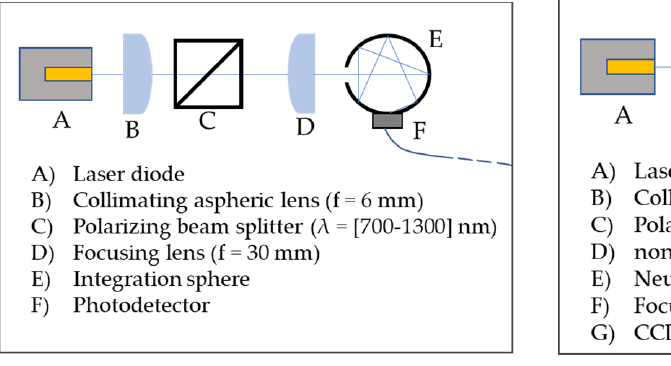
Figure 10. Measurement setup of ( a ) DoP; ( b ) slow axis near field. Figure 11 shows the polarization-resolved near-field slow axis (NFSA) for 324 HPLD devices with different DoP, ranging from 0.86 to 0.98. In particular, the TM-polarized NFSA reported in Figure 11a shows sharp peaks at the waveguide edges [3,26] when the DoP is high and spreads to the whole waveguide, about 200 μ m wide, when the DoP is decreasing. At the same time, the TE-polarized NFSA, reported in Figure 11b, shows an increase in optical filamentation with DOP decreasing. These effects, due to different mode excitation of the multimode lateral waveguide, are highlighted in the top color maps with the black shaded lines dividing regions of different behavior for high DoP (H) and low DoP (L), as a visual guide. The bottom images refer to single NFSA acquired for low-DoP and high-DoP devices, and clarify the NFSA shape discussed above.